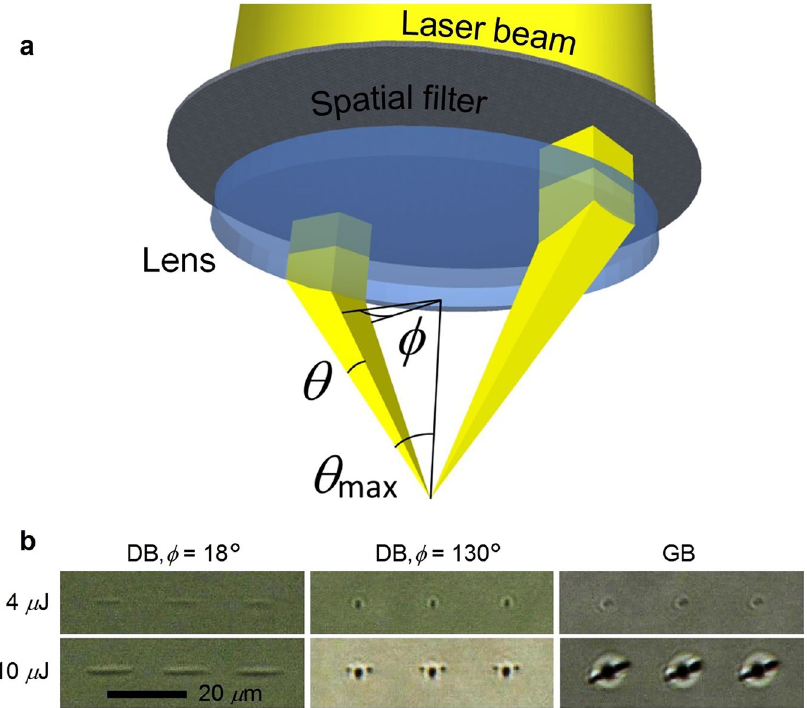
Figure 1. The Dual-Beam laser processing scheme: ( a ) focusing two parallel laser beams formed with a spatially filtered Gaussian beam, using two holes in a metal plate. ( b ) The Dual-Beam (DB) method tightens the laser induced structural modification spots (in one axis for low φ and in the two axes for high φ values) compared to a conventional Gaussian beam (GB) focusing. Each picture represents the top view of three fs-laser spots in glass for pulse energies of 4 and 10 μ J at 1030 nm wavelength focused with a 0.55 NA